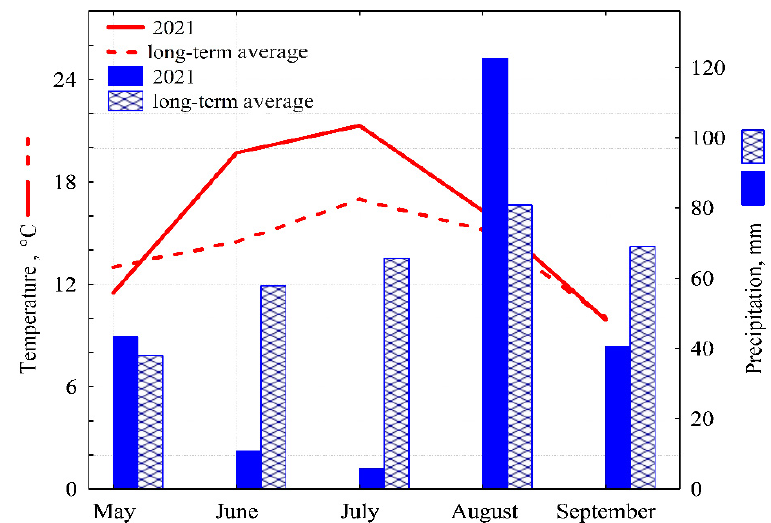
Figure 1. Mean monthly temperatures and rainfall in the experimental field during the 2021 growing season and long-term means for 1744–2020 (Pushkin and Pavlovsk Laboratories of VIR, Town of Pushkin, St. Petersburg, Russia). Source: Department of Automated Information Systems of Plant Genetic Resources, Hydrometeorological Station of VIR. Table 1. Productivity characteristics of table beet accessions. Duration of the growing season: 105 days. Results are presented as mean values with a standard deviation (Mean ± SD), the coefficient of variation (%CV), mean values with standard error (Mean ± SE), and the least significant difference (LSD 05